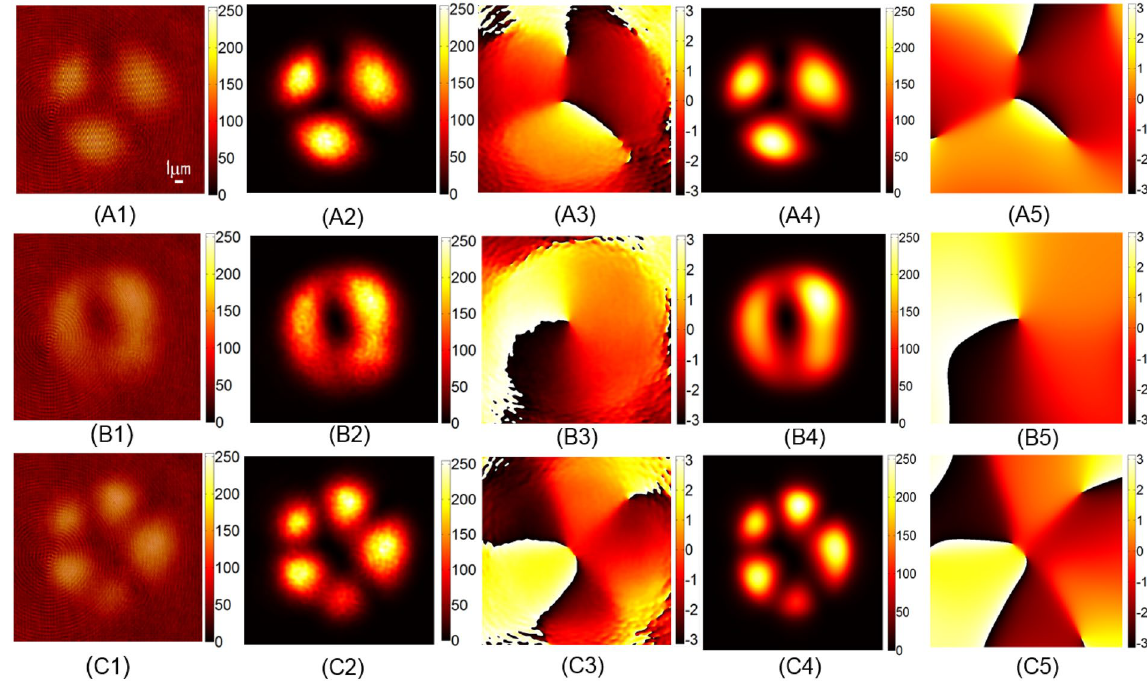
Figure 4. Modal decomposition results of the LMA fiber. ( A1 , B1 and C1 ) The holograms recorded by the camera. The ratio of the average power density between the object beams and the reference beams is about 1:1. ( A2 , B2 and C2 ) The intensity patterns reconstructed from the holograms. ( A3 , B3 and C3 ) The phase maps reconstructed from the holograms. ( A4 , B4 and C4 ), The intensity patterns synthesized by modal coefficients. ( A5 , B5 and C5 ) The synthesized phase